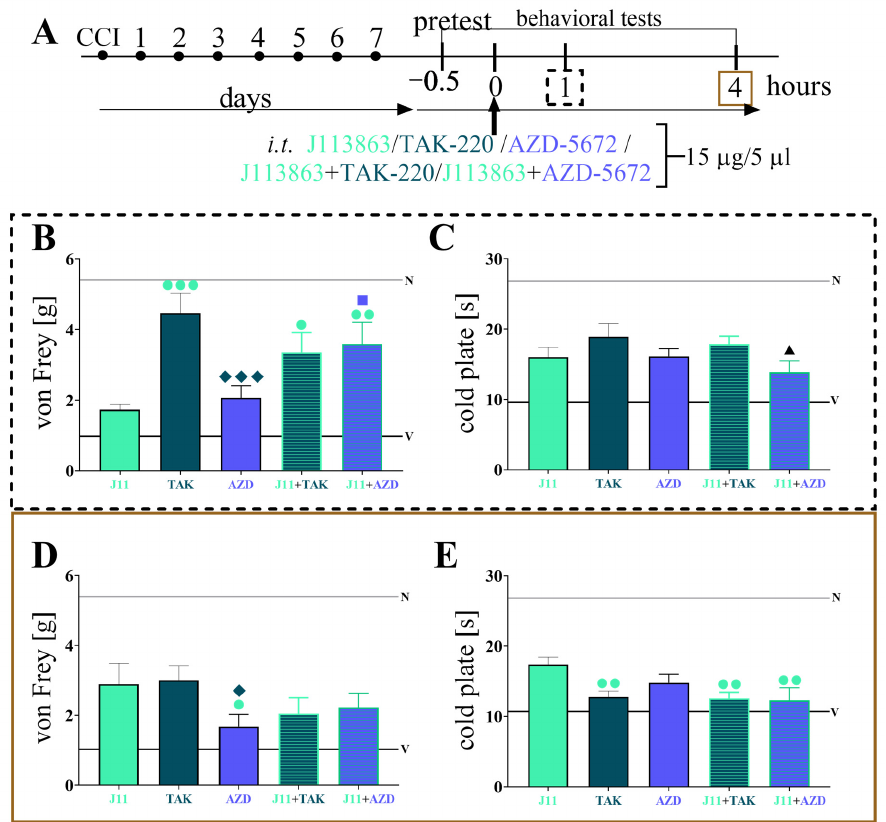
Figure 9 Figure 9. Comparison of the effects of intrathecal (i.t.) administration of substances targeting CCR1 (J113863), CCR5 (TAK-220 or AZD-5672), and their combination (J11 + TAK-220 or J11 + AZD-5672) at a dose of 15 µ g/5 µ L (timeline ( A )) on mechanical and thermal hypersensitivity measured after 1 h ( B , C ) and after 4 h ( D , E ), 7 days after chronic CCI in mice. The data are presented as the mean ± SEM (naive n = 5; CCI n = 7–8). The results were evaluated using one-way ANOVA followed by Bonferroni’s post hoc test for comparisons of selected pairs. • p < 0.05, •• p < 0.01, and ••• p < 0.001 indicate significant differences vs. J11-treated group; (cid:7) p < 0.05 and (cid:7)(cid:7)(cid:7) p < 0.001 indicate significant differences vs. TAK-treated group; (cid:4) p < 0.05 indicates significant differences vs. AZD-treated group; and (cid:78) p < 0.05 indicates significant differences vs. J11 + TAK-treated group. Abbreviations: N: naive; V: vehicle (DMSO); J11: J113863; TAK: TAK-220; AZD: AZD -5672;